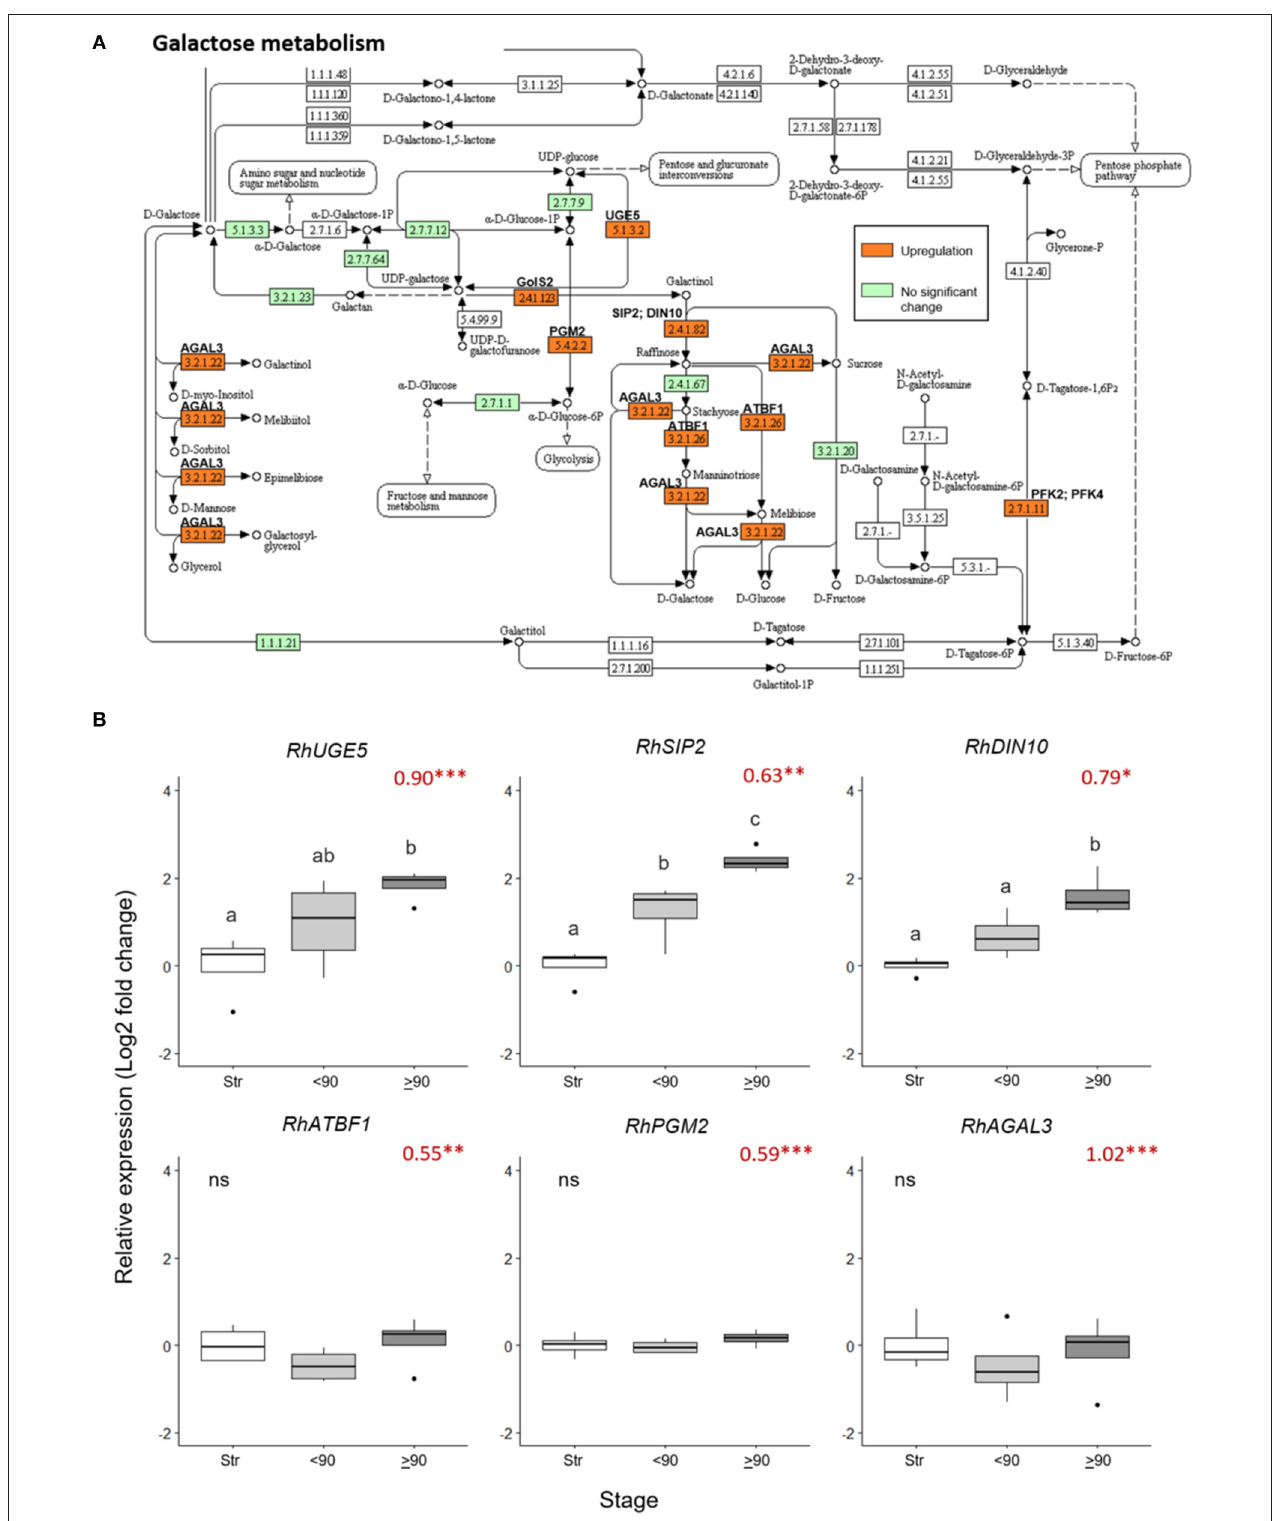
FIGURE 4 | Changes in expression of genes in the galactose metabolism pathway in > 90 ◦ bent compared to straight peduncles. (A) Pathway adapted from KEGG (rcn00052; Kanehisa, 2017) and showing EC codes for enzymes. Significantly upregulated genes (Log 2 FC > 0.5 and a p adjust. value < 0.05) are shown in